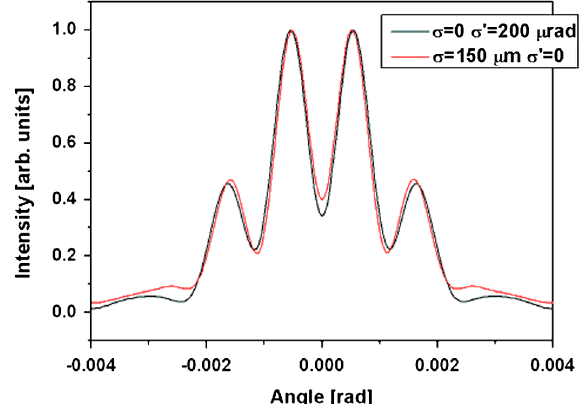
FIG. 4. Angular distribution produced by two different beams passing through a system of two collinear slits: a pointlike beam ( (cid:10) ¼ 0 , black curve) and a parallel beam, i.e., a beam without angular divergence ( (cid:10) 0 ¼ 0 , red